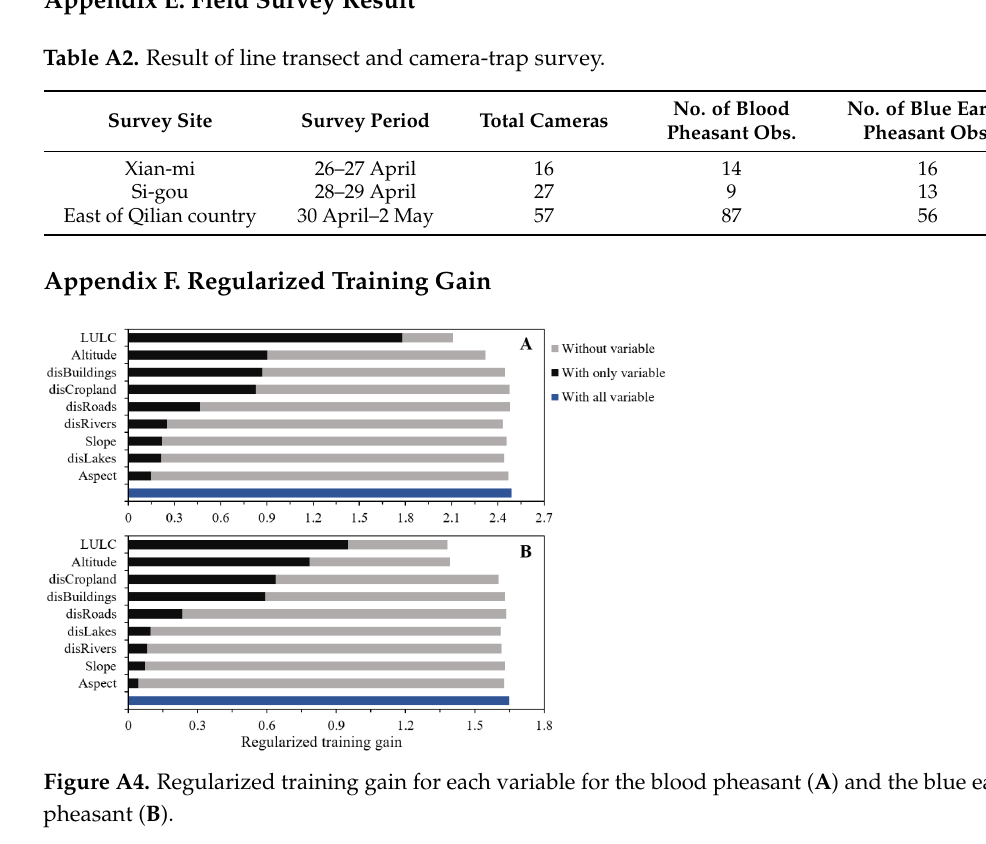
Table A3. Ecological niche fragmentation analysis. NP : number of isolated patches; LPI : largest patch index; PLAND : percentage of the landscape; CL : correlation length (or GYRATE_AM : area- weighted mean radius of gyration).